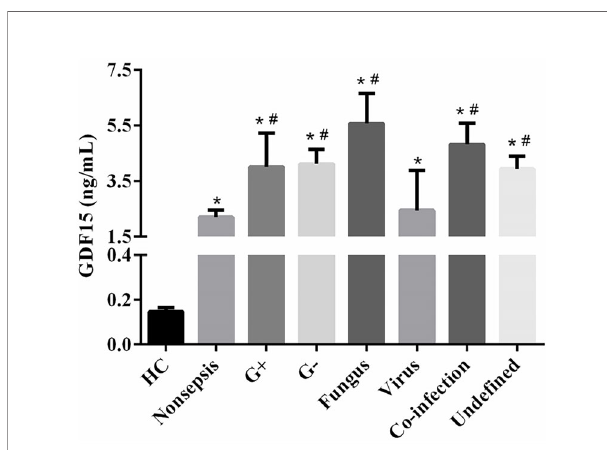
FIGURE 1 | Comparison of GDF15 levels in sepsis patients infected with different pathogens. * P < 0.05, compare with control group; # P < 0.05, compare with nonsepsis group.